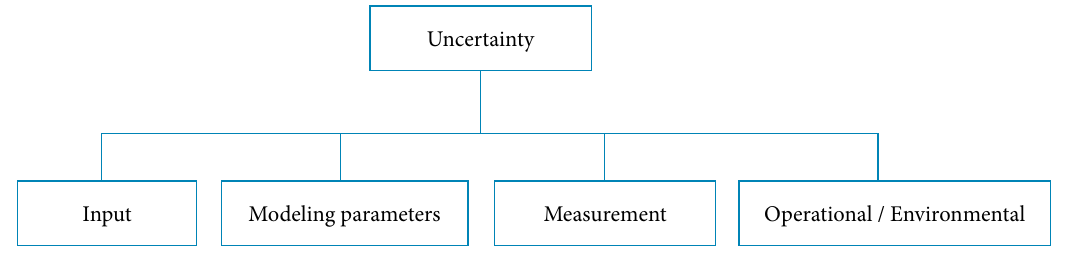
Figure 1. Uncertainty classification in systems analysis and